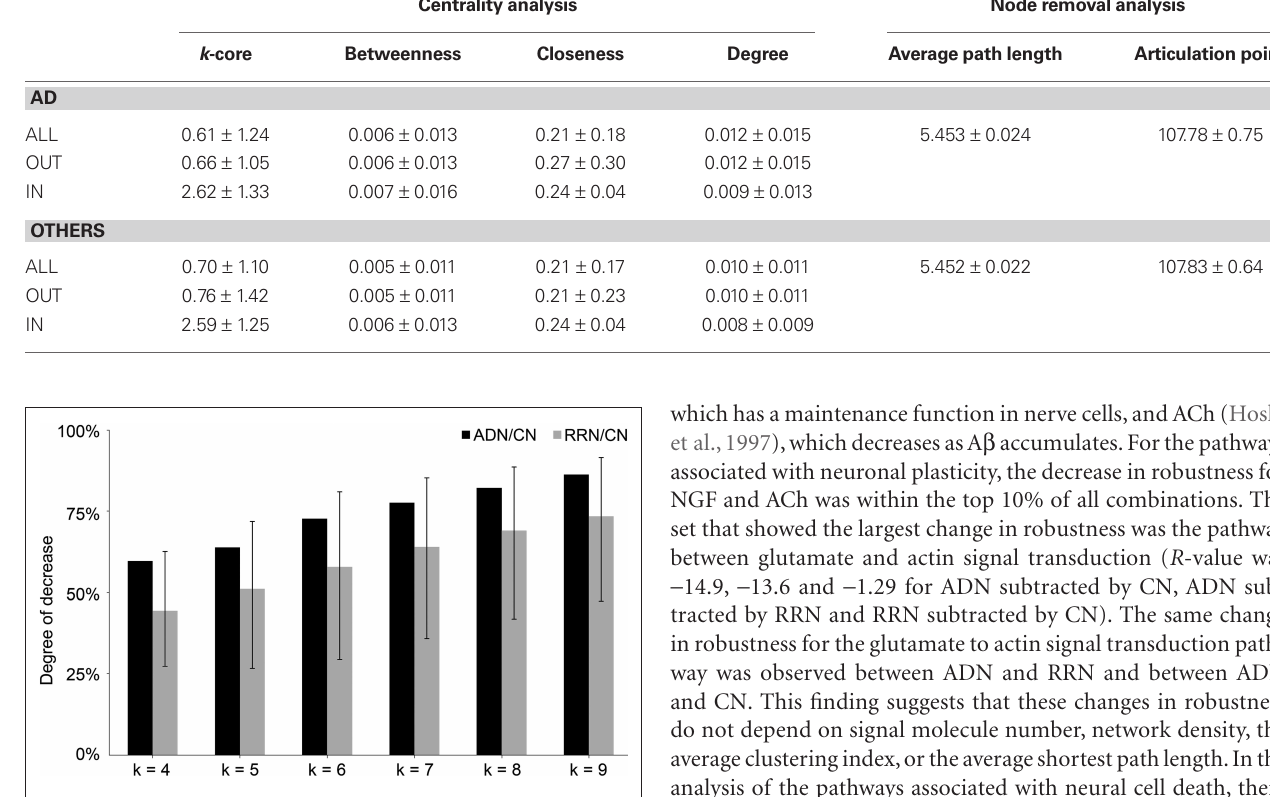
FIGURE 2 | Result of k -cycle structure rate of ADN/CN and RRN/CN. The X -axis represents step k and the Y -axis represents the rate of decrease. The error bar represents a top value of 95% and a bottom value of 5%. We used RRN with a random Alzheimer’s disease-related signal molecule set, in which the rate of change in the three indicators (network density, average clustering index, and average shortest path length) is within 5%. By comparing the number of k -cycle structures ( k = 4, 5, … , 9) of RRN, CN, and ADN, we showed that the all-step k value decreased. However, the graph shape was similar for each cycle structure number corresponding to the steps; the correlation coeffi cient between ADN/CN and RRN/CN was 0.99. This fi nding also demonstrates that network size, not external factors, has an effect on cycle